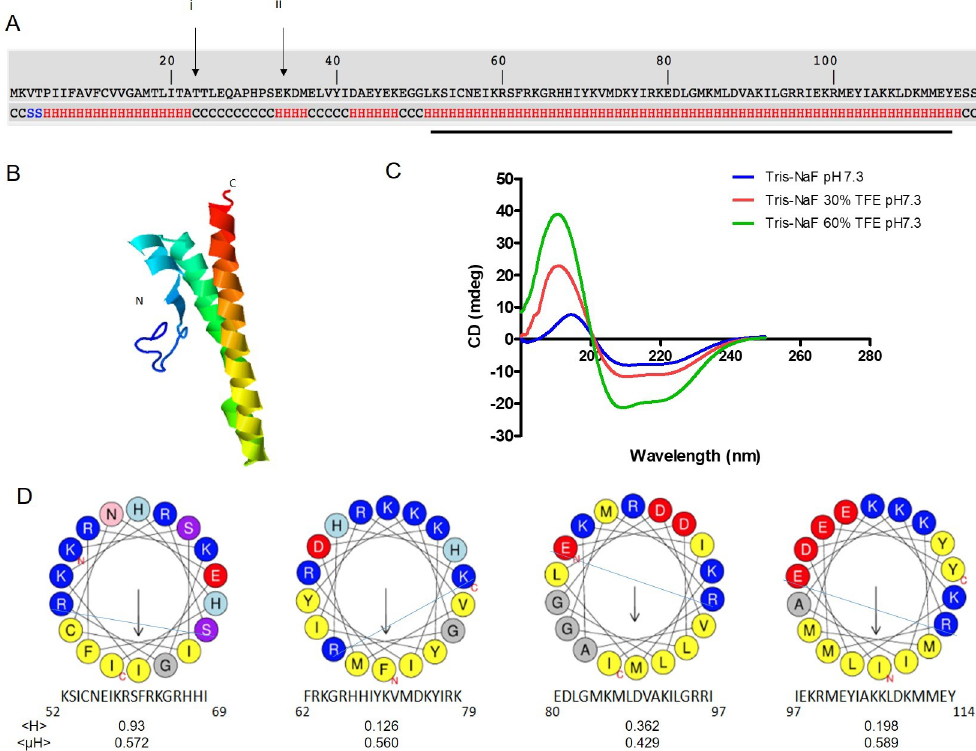
Fig 2. Sm16 predominantly consists of an amphipathic alpha helix. (A) Predictive secondary structure of Sm16 generated using I-TASSER: H–Helix; S–Strand; C–coil. Arrow (i) denotes the SignalP 4.1 predicted cleavage site for an N-terminal secretory signal peptide between residues 22 and 23, and arrow (ii) shows the commencement of the synthetic Sm16 (34– 117) peptide sequence. The black line indicates the portion of Sm16 that is amphipathic. (B) 3D model of full length secreted Sm16, generated using I-TASSER (C) Circular dichroism analysis performed on recombinant Sm16 in the absence of tetrafluoroethylene (TFE), in 30% TFE, and 60% TFE. (D) Helical wheel analysis of Sm16 performed using HeliQuest identified four hydrophobic faces (indicated by blue line through helix) in continuous succession in the amphipathic C- terminal helix. < H > —Hydrophobicity; < μ H > —Hydrophobic